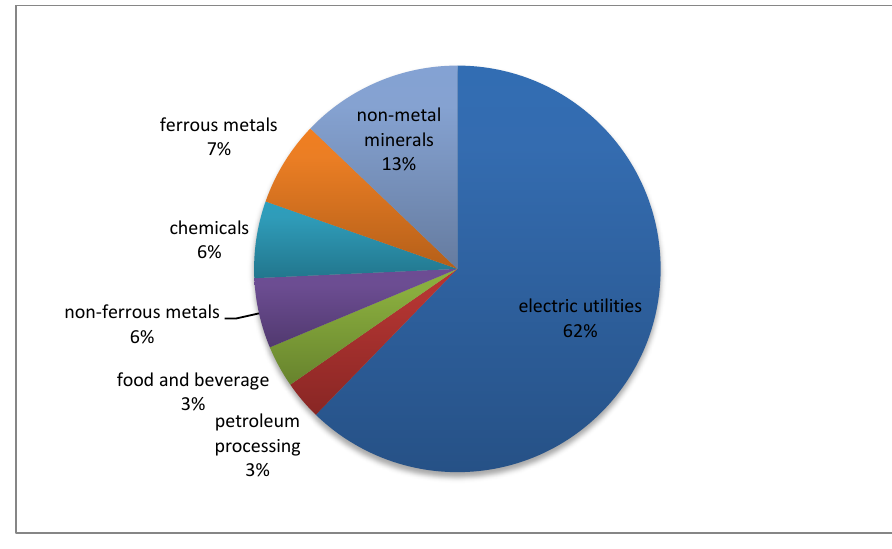
FIGURE 3: Sources of emissions in China (2006)